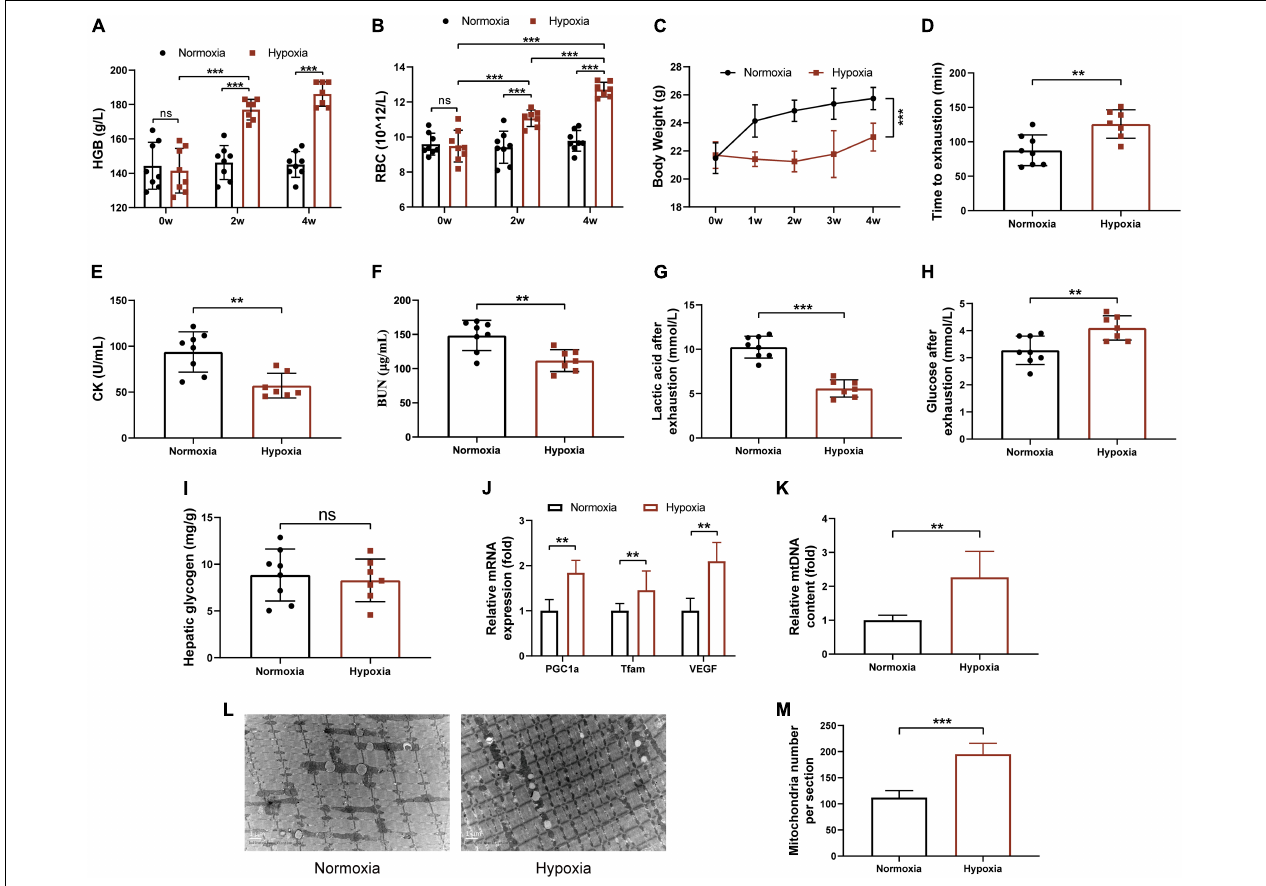
FIGURE 1 | Hypoxia exposure improved endurance performance of mice. HGB (A) and RBC (B) in the tail blood were detected. (C) Body weight was measured once a week. (D) Time to exhaustion was recorded. After exhaustion, CK (E) , BUN (F) , lactic acid (G) , and glucose (H) were measured immediately. (I) The hepatic glycogen was measured. The expression of PGC-1 α , Tfam, VEGF (J) , and the mtDNA (K) content were measured by RT-PCR. (L) Representative TEM images of gastrocnemius at a magnification of 12,000 × . (M) Quantification of the number of mitochondria per section. Data are presented as means ± SD. * p < 0.05, ** p < 0.01, *** p < 0.001 (Student’s t